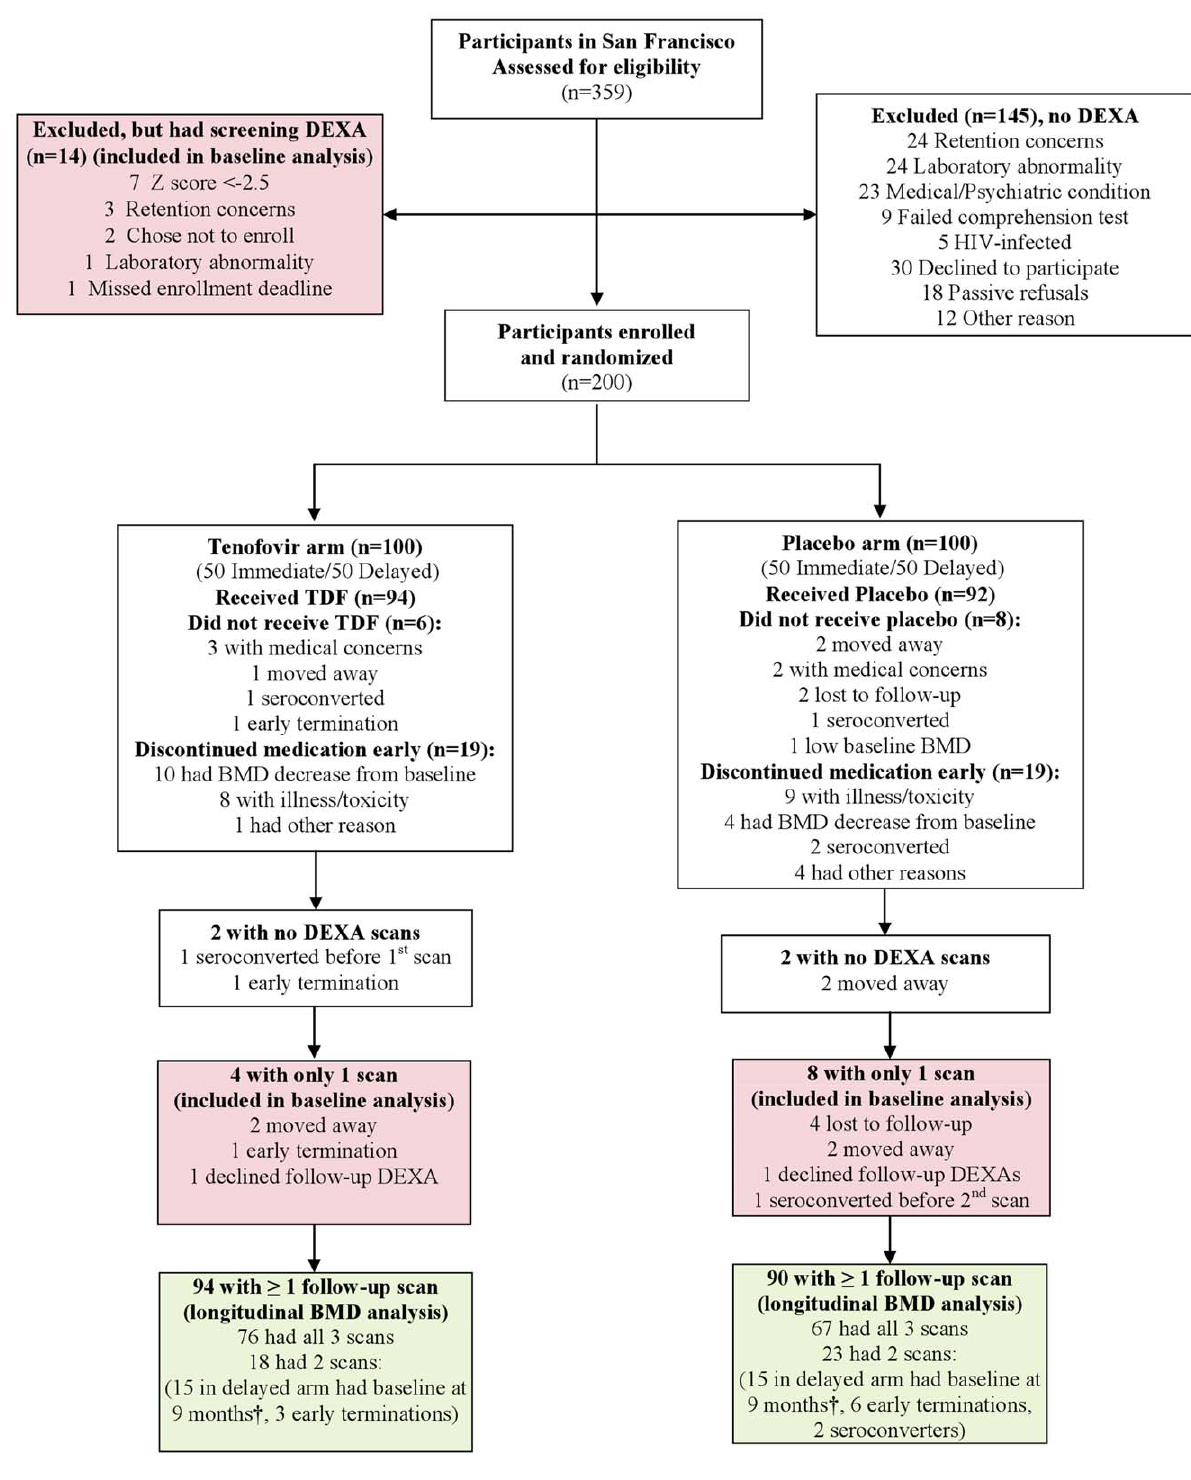
Figure 1. Study design and participant disposition. The baselineonlycohort shown in red shading includes 26 men who had only 1 DEXA scan performed, either during screening or after enrollment. The longitudinal cohort shown in green shading includes 184 men who had a baseline and at least 1 additional scan during study follow-up. Of the 210 participants who had a baseline DEXA scan, 178 had this scan performed during screening, and 32 shortly after enrollment (prior to the protocol amendment moving DEXA scans to screening). { Delayed arm participants who enrolled prior to protocol amendment had baseline DEXA performed at 9 months prior to starting study drug. DEXA, dual energy X-ray absorptiometry; TDF, tenofovir disoproxil fumarate.